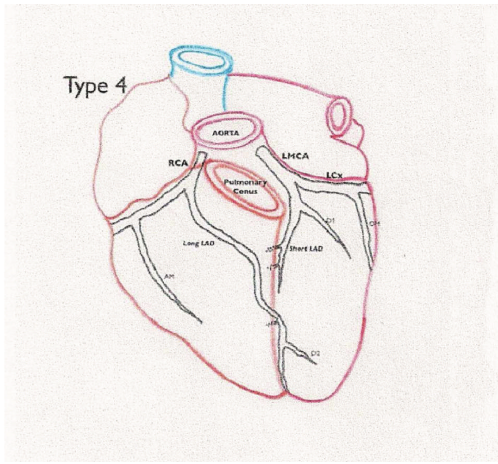
Figure 3: Type 4 dual LAD configuration by Spindola-Franco et al. RCA: right coronary artery; LMCA: left main coronary artery; LAD: left anterior descending artery; LCx: left circumflex artery. Reprinted with permission from